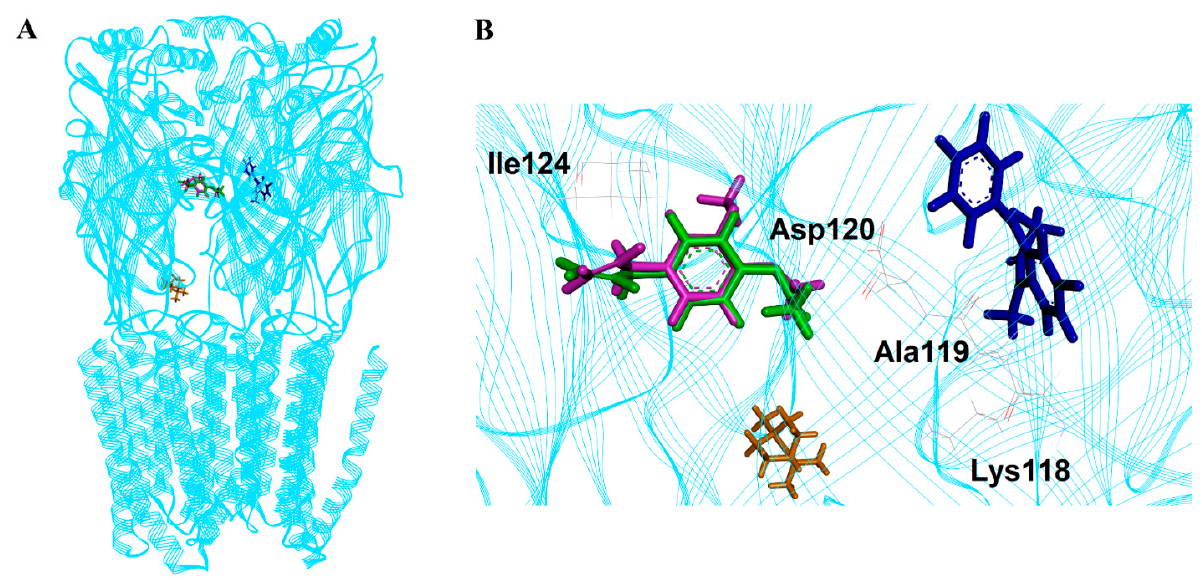
Figure 4. ( A ) The binding locations of the ligands; methyl eugenol (pink), 1,8-cineole (orange), 4-allylphenyl acetate (green), and diazepam (blue) on GABA A receptor (light blue); ( B ) closed view of the docking compounds at the binding locations and the adjacent amino acid residues of the E chain.